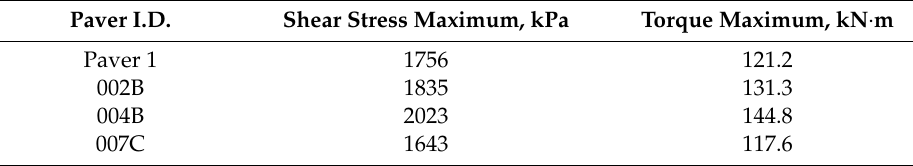
Table 1. Shear test